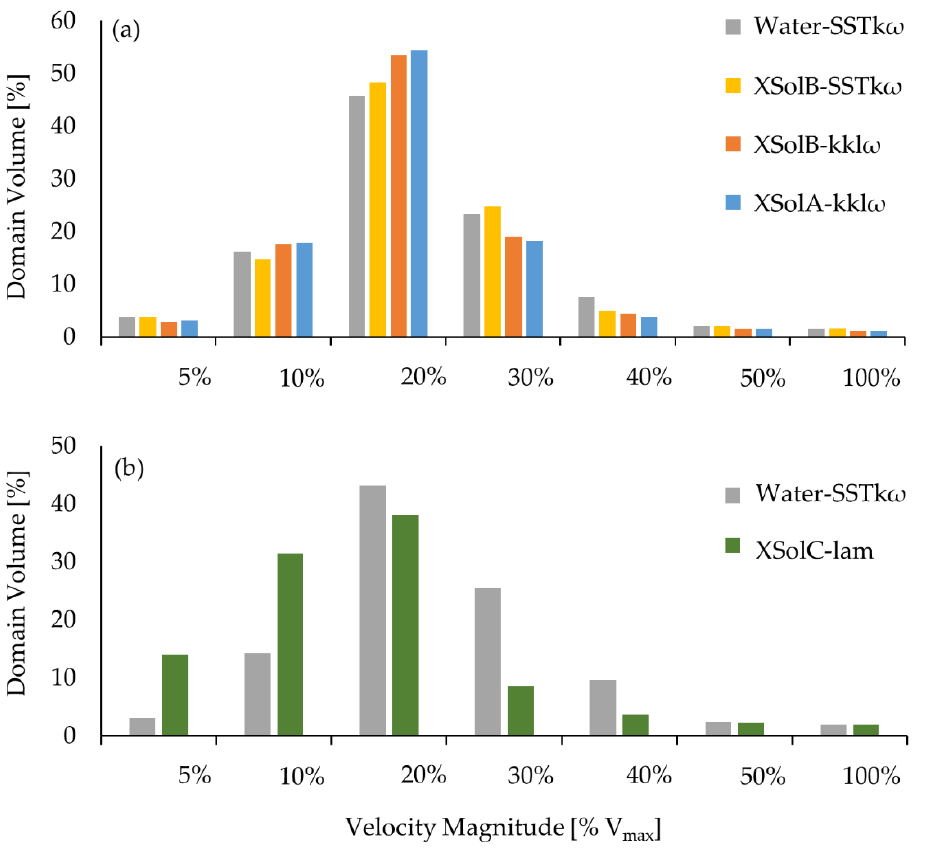
Figure A15. Analysis of velocity magnitude distribution for the quantification of dead zones volume, when the system evolves ( a ) from water to Xanthan Sol B and Xanthan Sol A, and ( b ) from water to Xanthan Sol C.